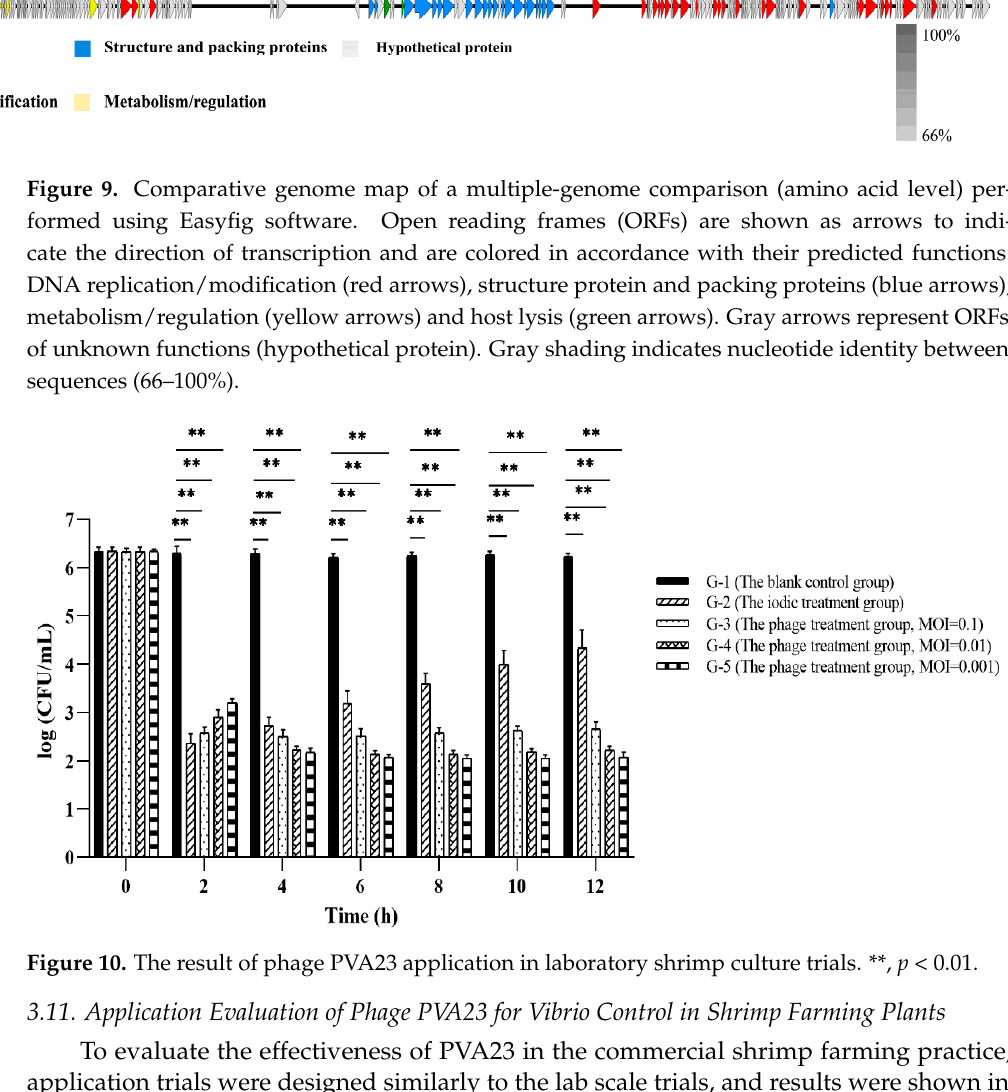
Figure 11. Application evaluation of PVA23 against Vibrio in commercial shrimp farming plants. In experiment, it was hard to manage to get identical Vibrio counts in different ponds, the ponds with Vibrio ≥ 1000 CFU/mL were selected for the trials and each trial repeated. Vibrio counting in the chosen ponds were real, though they might be varied among ponds to some extent. *, p < 0.05, **, p < 0.01.